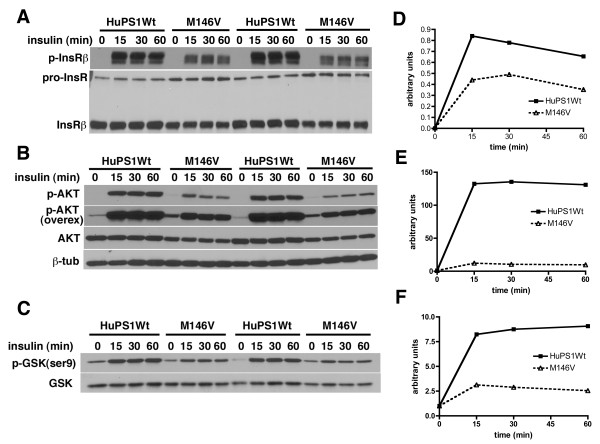
Decreased insulin-induced activation of the insulin receptor, Akt and GSK-3β in fibroblasts harboring the M146V Psen1 FAD mutation. In panel A, human wild type Psen1 (HuPS1Wt) or M146V FAD mutant cell lines were serum starved overnight and then stimulated with insulin for the indicated times. Western blotting for the phosphorylated IR receptor β (Tyr 1150/1151) or total IR is shown in experiments run in duplicate. The pro-insulin receptor and processed IR are indicated. In panel B, duplicate experiments are shown following Western blotting for p-Akt (Ser473) and total Akt. p-Akt panels are shown at two different exposures. Lower panel shows the blot reprobed for β-tubulin as a loading control. In panel C, the extracts were blotted and probed for p-GSK-3β (Ser9) and total GSK-3β. In panels D, E and F the relative increase in p-IR/total IR (D), p-Akt/total Akt (E) and p-GSK-3β/total GSK-3β (F) are shown for the experiments in A-C.